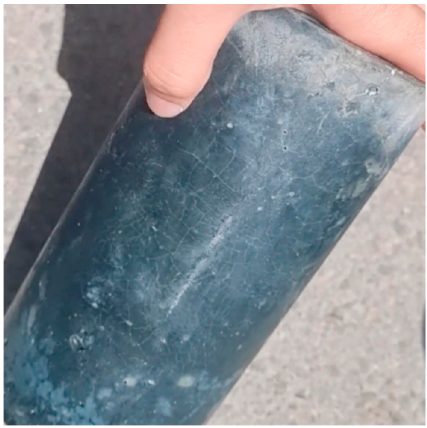
Figure 6. Cracking on Geopolymer Cylindrical Specimen prior to Experimental Testing.